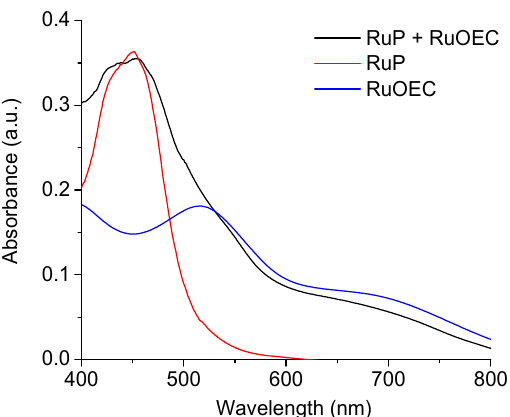
Figure 1. Absorption spectra of photoanodes sensitized in ruthenium(II)bis(2,2 ′ -bipyridine)([2,2 ′ - bipyridine]-4,4 ′ -diylbis(phosphonic acid)) dibromide (RuP) for 1 h; ruthenium(II) tris(4- methylpyridine)(4-(4-(2,6-bis((l1-oxidanyl)carbonyl)pyridin-4-yl)phenyl) pyridine-2,6-dicarboxylic acid (RuOEC) for 16 h; and with RuP for 1 h and then RuOEC for 16 h. a.u.: Arbitrary units.